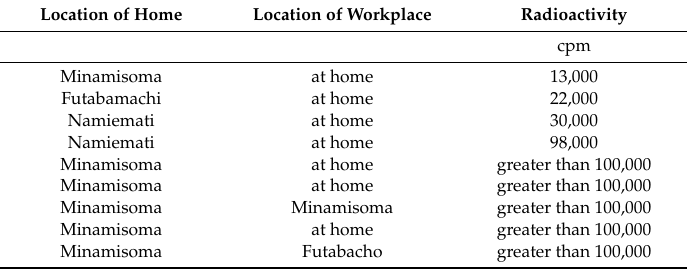
Table 1. Exposure levels of people tested at the hospital in Minamisoma (Figure 1, area number 1) on 14 March 2011. Location of Home Location of Workplace Radioactivity cpm Minamisoma at home 13,000 Futabamachi at home 22,000 Namiemati at home 30,000 Namiemati at home 98,000 Minamisoma at home greater than 100,000 Minamisoma at home greater than 100,000 Minamisoma Minamisoma greater than 100,000 Minamisoma at home greater than 100,000 Minamisoma Futabacho greater than